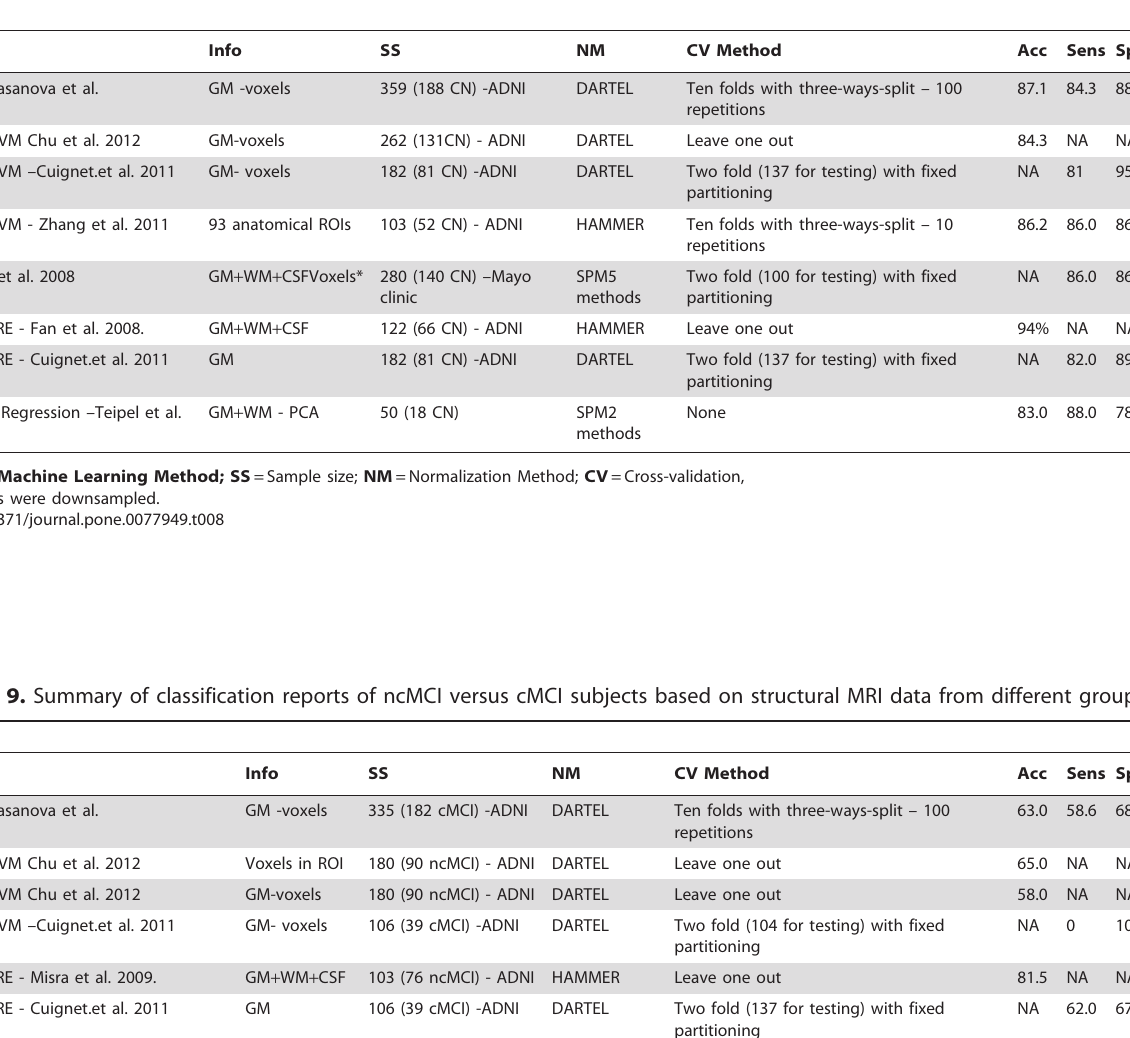
Table 8. Summary of classification reports of CN versus AD subjects based on structural MRI data from different groups.